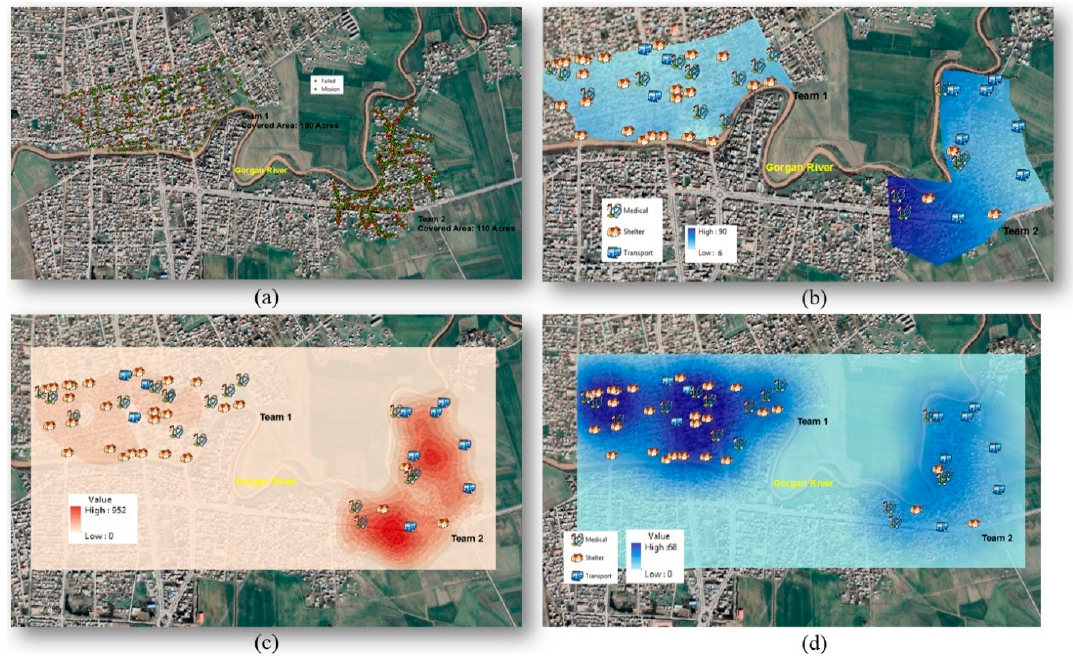
Figure 12. ( a ) Location and the extent of relief mission on both sides of Gorgan River in Aqala, ( b ) water inundation rate in two test zone, ( c ) Unresolved problem density map on the sixth day, ( d ) Density and diversity map of performed services on the sixth day without considering the food distribution service.